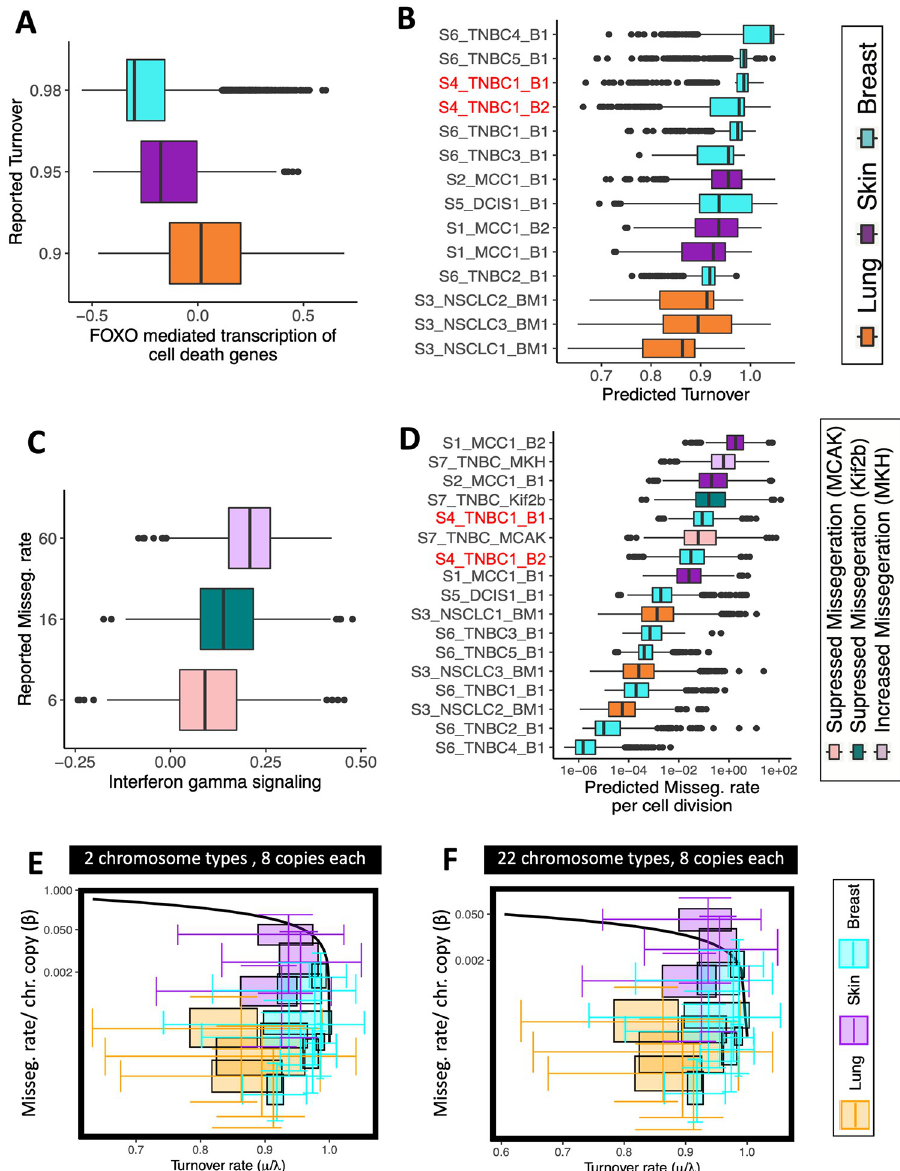
Fig 3. Predicting proximity of a PAN-cancer cohort to MIE. (A-D) Quantification of mis-segregation and turnover rates. (A) Expression of regulators of cell death genes (x-axis) varies across tissue sites (color code) along with turnover rates reported for tumors of the same origin (y-axis; adjusted R 2 = 0.999; P = 0.07). (B) A regression model was built from (A) and used to predict turnover rate in 15,464 cells across 14 tumors. (C) Interferon Gamma gene expression (x- axis) measured in 7,879 cells from three human breast cancer cell lines [59] (color code) varies with their % lagging chromosomes quantified from imaging (y-axis; adjusted R 2 = 0.88; P = 0.157). (D) A regression model was build from (C) and used to infer turnover rate in 23,343 cells across 17 tumors. (E,F) Empirically inferred missegregation- ( β ), and turnover rates ( μ / λ ) are displayed alongside the theoretical critical MIE curve calculated for two chromosome types (E) and all 22 autosomes (F). The interval of viable karyotypes is between one and eight copies for each chromosome type. inference of mis-segregation rates per cell division per chromosome for each subpopulation (Fig E in S1 Text). The variability in missegregation rates and the proximity of turnover rates to homeostasis warrants further investigation into whether increasing missegregation rate is a potential